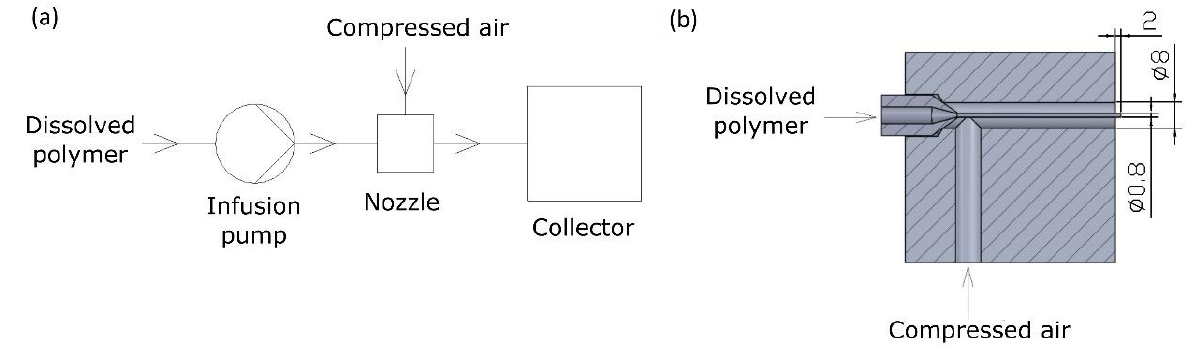
Figure 2. Scheme of the solution blow spinning setup ( a ) and cross-section through the nozzle ( b ). The nozzle consisted of two concentric channels, as shown in Figure 2b. The polymer solution was pumped through the inner one via a syringe placed in the infusion pump, while the compressed air was released through the outer one. A compressed air stream accelerated the polymer solution at the end of the channel. As a result, a cone was formed from the collected solution. If air with sufficiently high pressure is used, solution streams are entrained at the tip of the cone, from which solidified fibers are formed when the solvent is